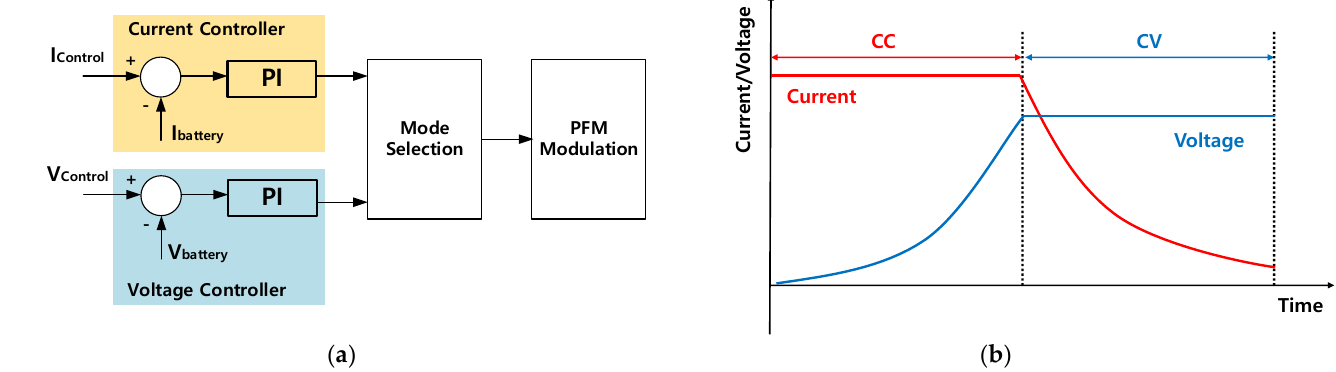
Figure 5. Charging Algorithm: ( a ) Control structure during charging mode; ( b ) CC – CV curve.